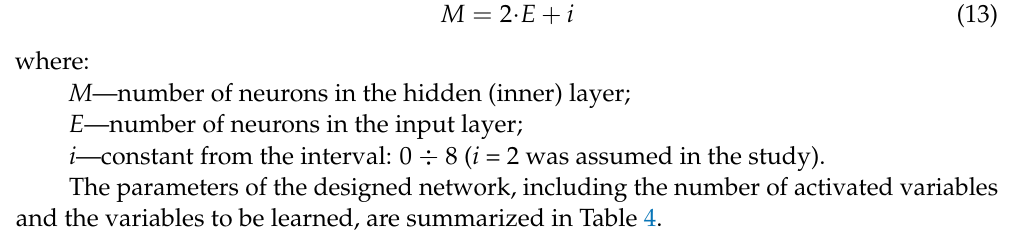
Table 4. Main network